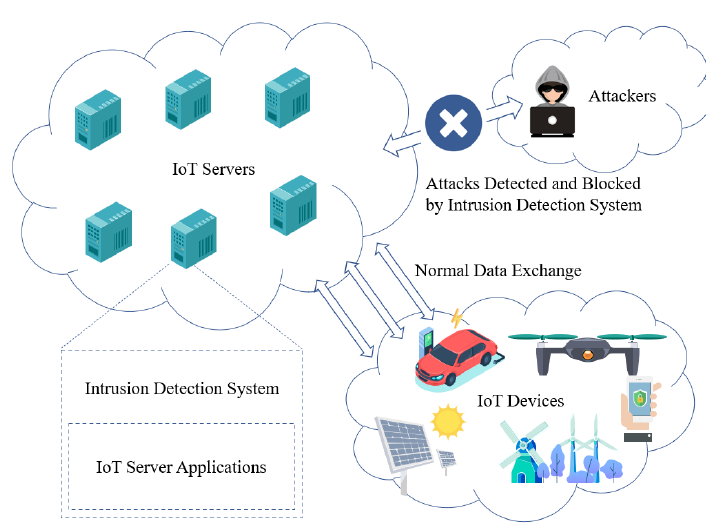
Figure 1. The Scenario of the IDS applied in the IoT